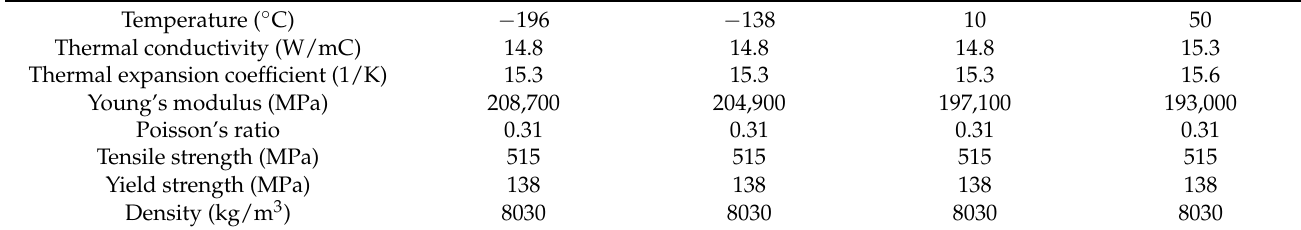
Table 1. Properties of stainless steel [21].